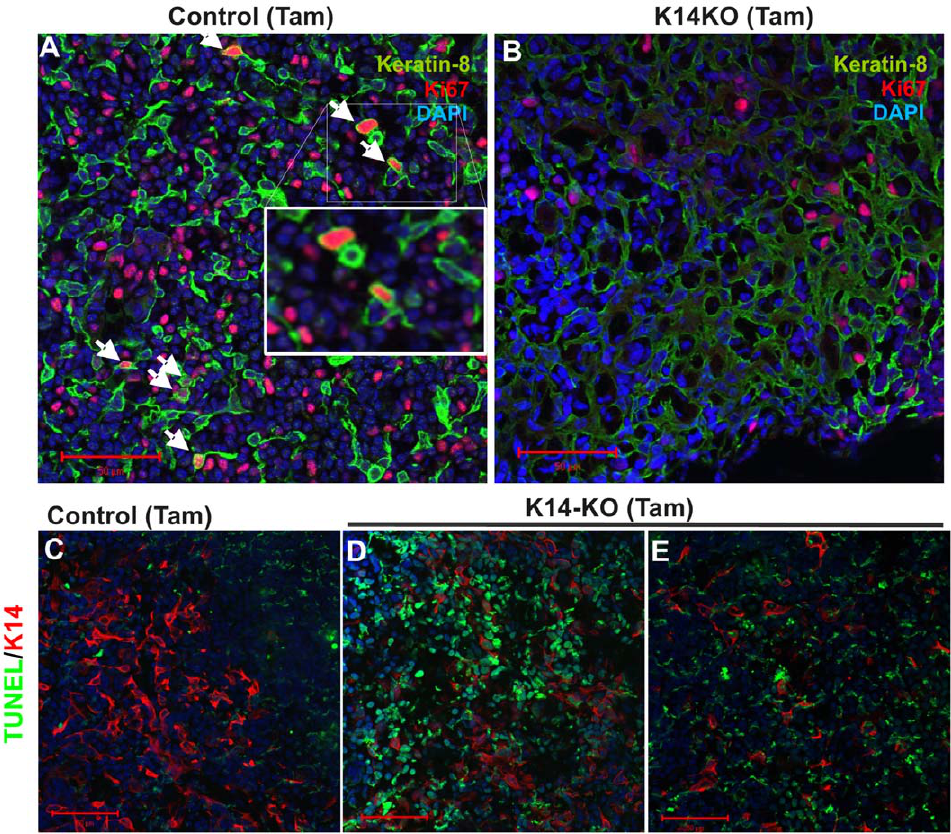
K5CrexRac1 flox/flox (I–L). Scale bars 50 m m. (M–O) Impaired thymic selection with increase of the CD4/CD8 double negative population in tamoxifen treated K14CreERxRac1 flox/flox mice (N) and K5CrexRac1 flox/flox (O) compared with tamoxifen treated wild type mice (M). (TIF) Figure S2 Loss of Rac1 results in up-regulation of c-Myc. (A–D) Tamoxifen treatment of K5CrexRac1 flox/flox results in increase immunofluorescence staining of c-myc in 6 week old remnant thymi (A–D). Addition of tamoxifen to K14CreERxRac1 flox/flox (K14 + Tam) derived Fetal Thymic Organ Cultures causes increased c-Myc expression (E and F) compared to controls (K14 no Tam) (B and C). Scale bars 50 m m. (TIF) Table S1 Proportions of CD3 and CD8 positive peripheral T cells from spleens tamoxifen treated wild type, tamoxifen treated K14KO and K5KO